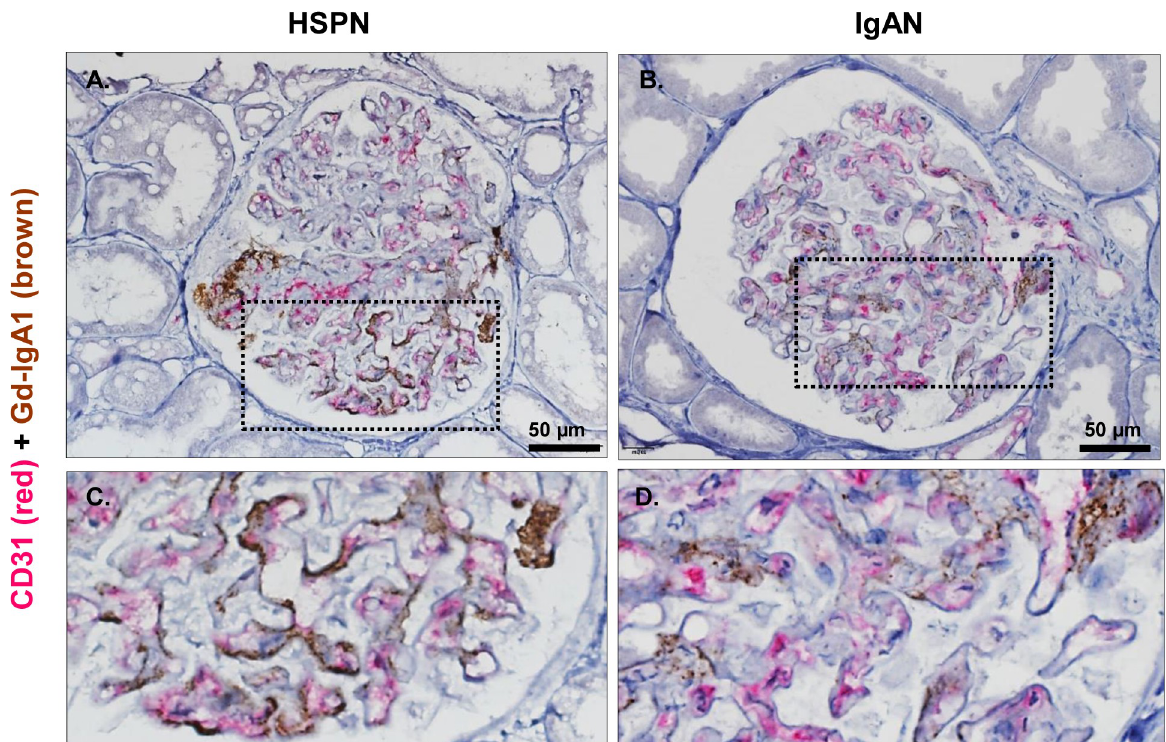
Fig 5. Double immunostaining for CD31 with Gd-IgA1 between HSPN and IgAN samples. Paraffin-embedded kidney sections were stained using 2-color immunohistochemistry with CD31 stained red and Gd-IgA1 stained brown. Representative photos of double staining for CD31 with Gd-IgA1 in patients with HSPN ( A and C ) or IgAN ( B and D ). The boxed area with broken lines in the upper panels ( A and B ) is enlarged in the lower panels ( C and D ). Original magnification: ×